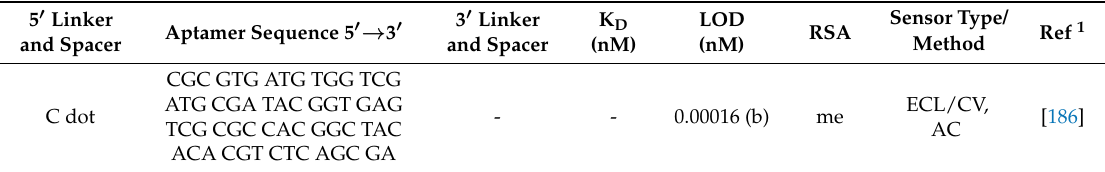
Table 14. Aptamer sequence, dissociation constant (K D ), limit of detection (LOD), real sample analysis (RSA) and realized sensor type and measuring method for lincomycin, mentioned in the corresponding references (Ref). AC = alternating current, b = buffer, CV = cyclic voltammetry, ECL = electrochemiluminescent, and me = meat.